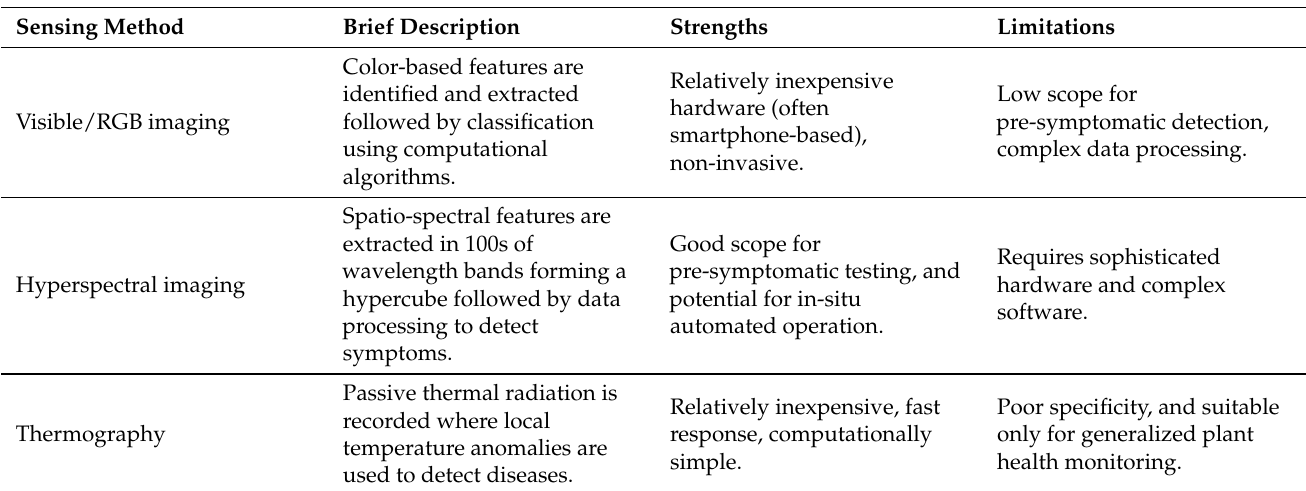
Table 2. Brief qualitative comparison of the indirect sensing methods discussed in this article for monitoring phy- topathogenic stress in